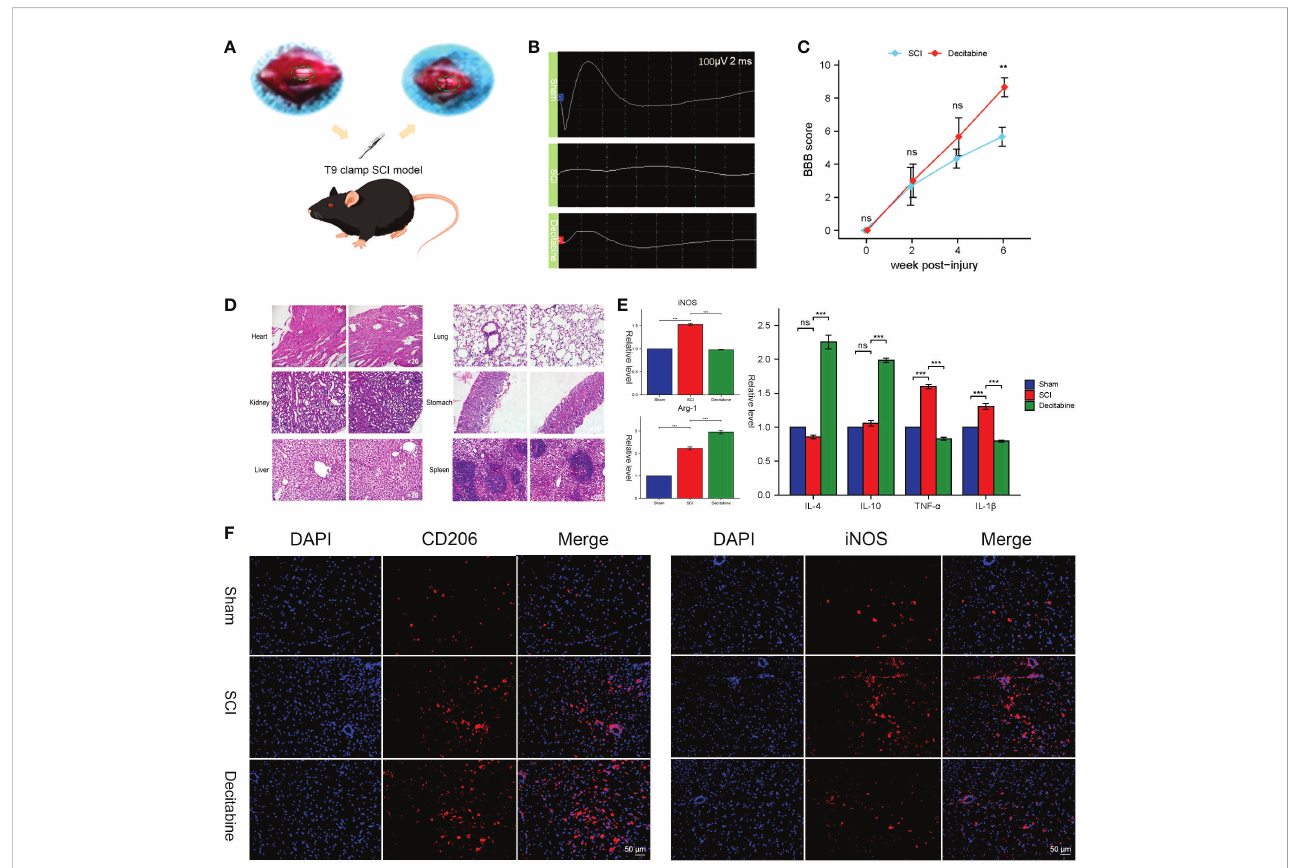
FIGURE 9 In vivo functional and histological assessment. (A) The spinal cord injury model of T9 by arterial clamp. (B) Electromyography was observed at 6 weeks post-SCI in uninjured group, the SCI + phosphate-buffered saline (PBS) group and the SCI + decitabine group. (C) The Basso-Beattie-Bresnahan locomotion testing score at 6 weeks post-SCI in the SCI + PBS group and the SCI + decitabine group ( n = 6 in each group). (D) HE-stained sections of the heart, liver, spleen, lung and kidney of the mice at 6 weeks post-SCI in the SCI + decitabine group (magni fi cation, ×200). (E) The expression level of iNOS, Arg, IL-4, IL-10, TGF- a , and IL-1 b at 2 weeks in uninjured group, the SCI + PBS group and the SCI + decitabine group. (F) The immuno fl uorescence staining of CD206 and iNOS at 2 weeks post-SCI. &Statistically signi fi cant difference appeared on this day. ** P < 0.01, *** P <